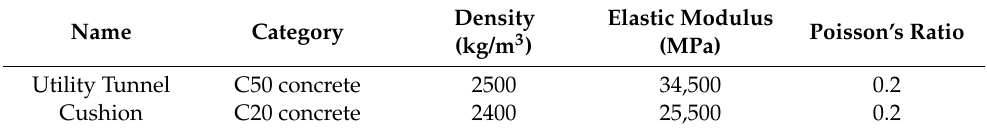
Table 2. Material parameters of the utility tunnel and cushion.